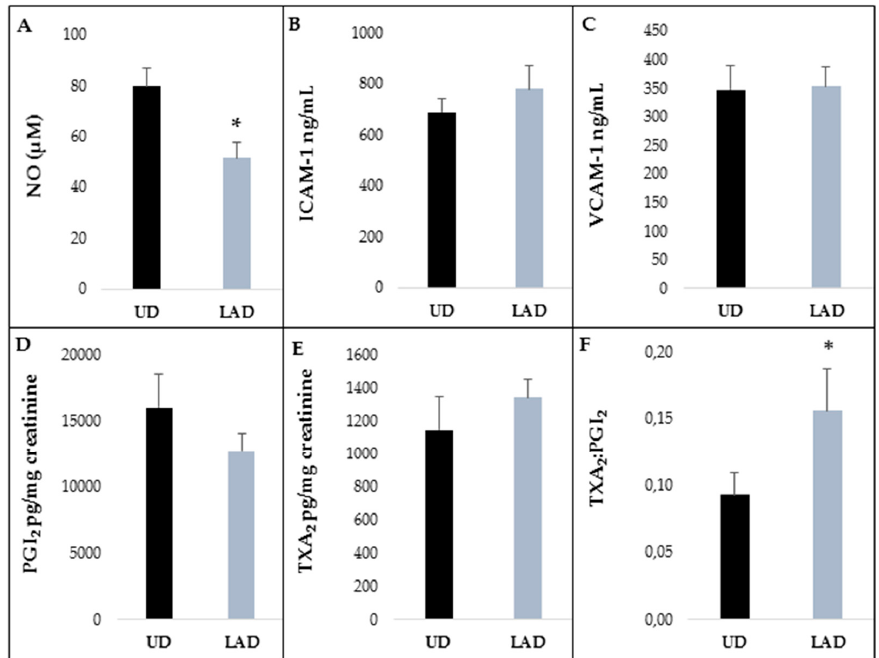
Figure 4. ( A ) NO ( B ) ICAM-1 ( C ) VCAM-1 ( D ) PGI 2 ( E ) TXA 2 and ( F ) ratio TXA 2 /PGI 2 between both interventions. Data shown are mean ± SEM. The UD is in black and the LAD is in gray; * significant differences with p < 0.05.